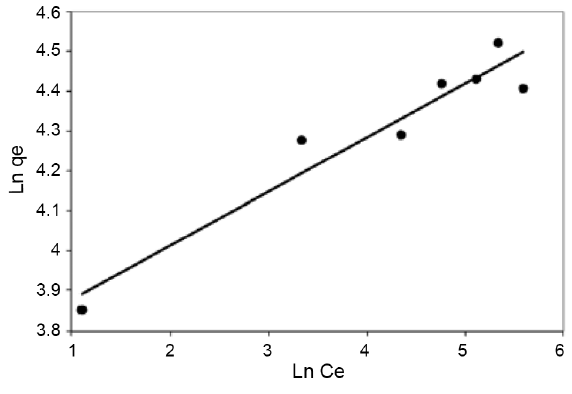
Fig. 5. Freundlich isotherm plot of ln q e vs. ln C e for biosorption of nickel ions onto pre-treated FGWS. D p = 62.2 µm